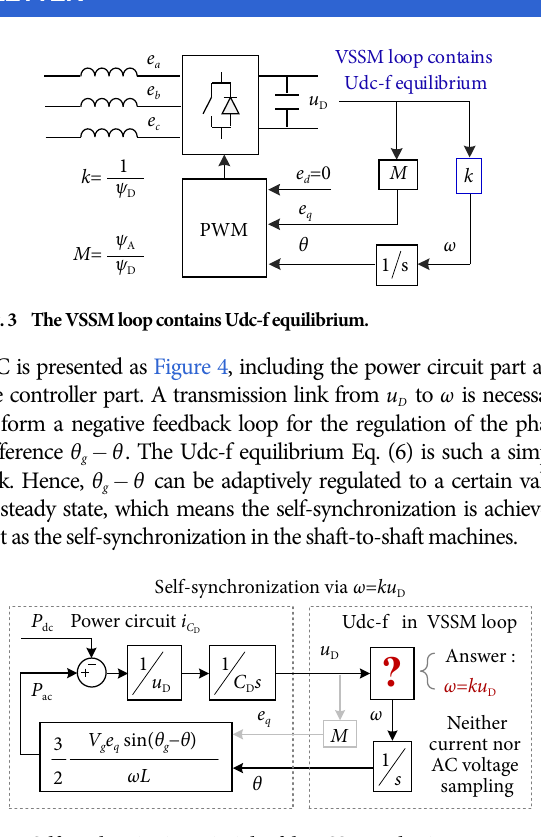
Figure 5. The main parameters are listed in Table 2.